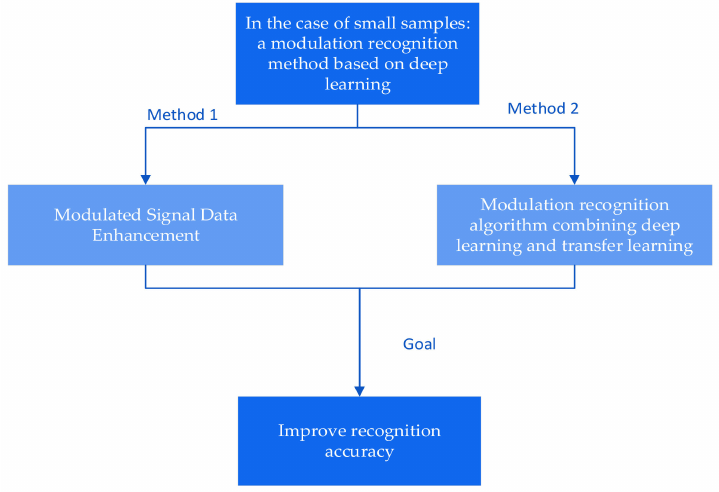
Figure 13. Modulation identification in the case of small